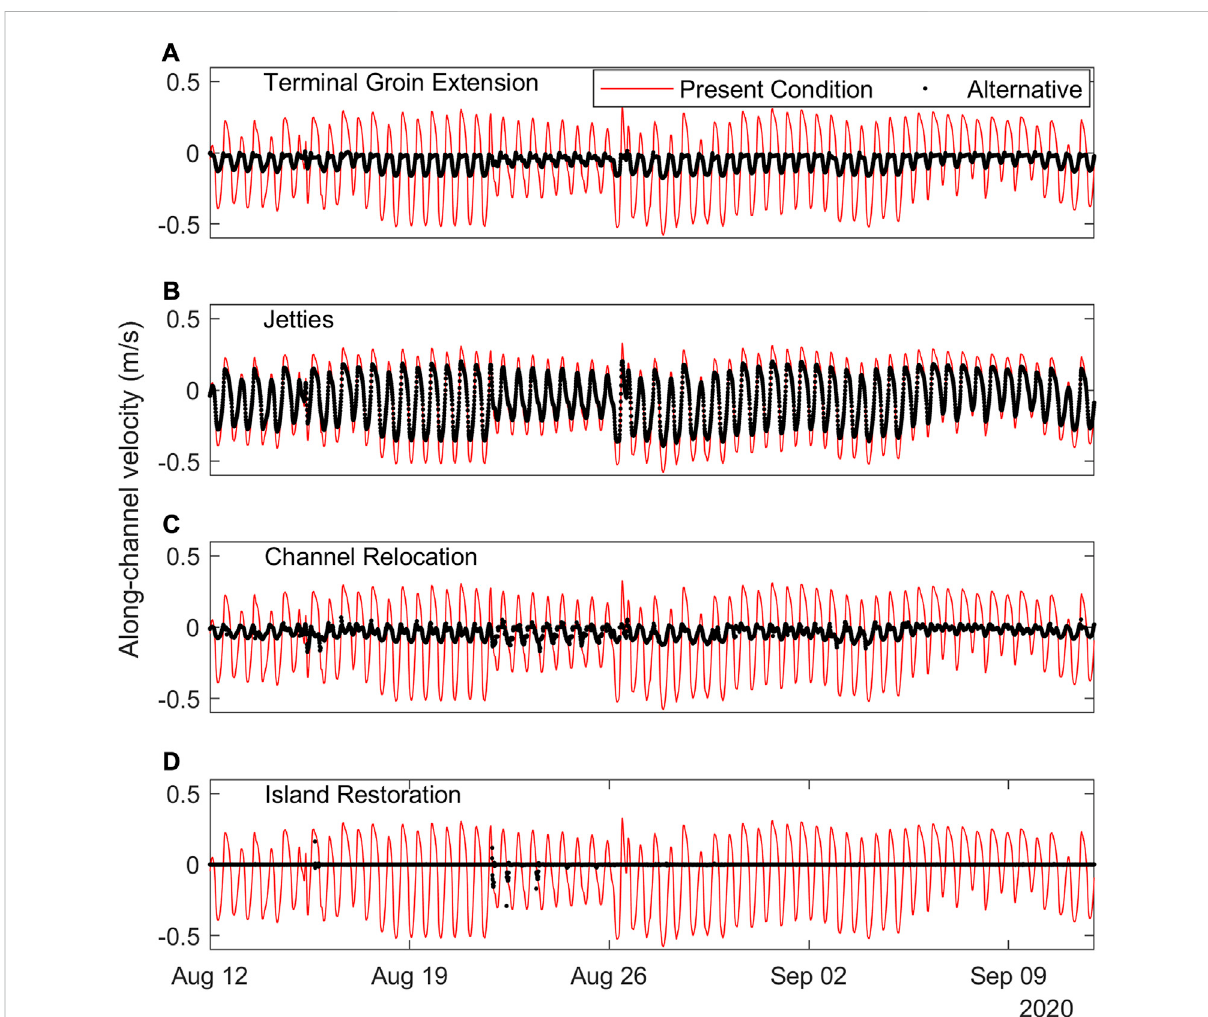
FIGURE 5 Depth-averaged along-channel velocity in the “ South ” location near the shoreline (Figure 1C) during the present condition (red line) and under coastalprotection alternatives(black points) versustime.Positive velocityisto thesoutheast( fl ooding),negativevelocityistothenortheast(ebbing). Alternatives include the (A) terminal groin extension (B) jetties, (C) channel relocation, and (D) island restoration; seawall and bendway weir alternatives are not shown.